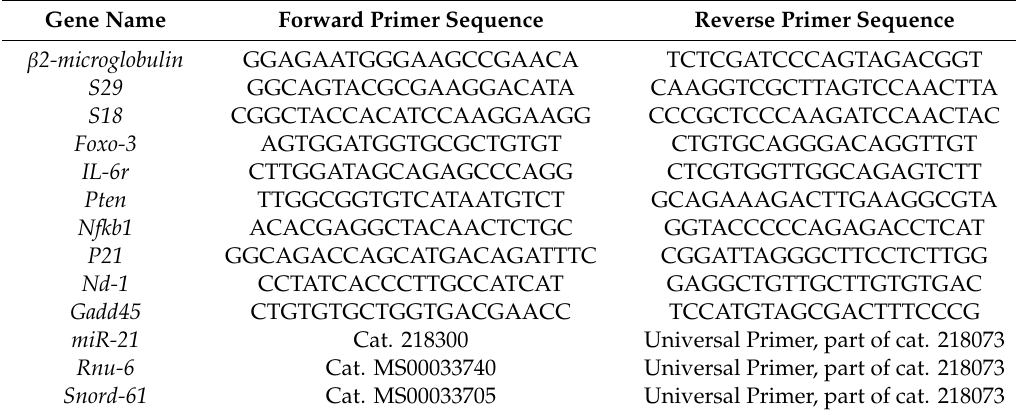
Table 1. Sequences of primers used for qPCR.